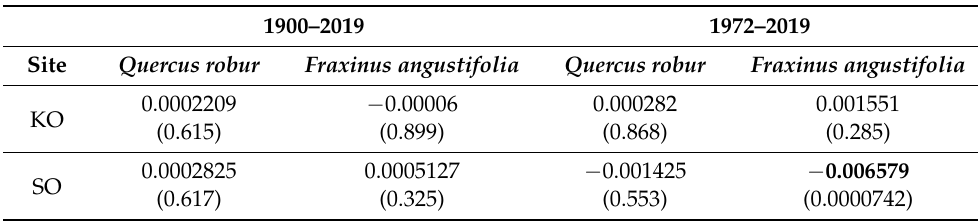
Table 2. Slopes of linear fits for RWI100 chronologies (1900–2019, 1972–2019). Significant values are in bold ( p -values are in parentheses).